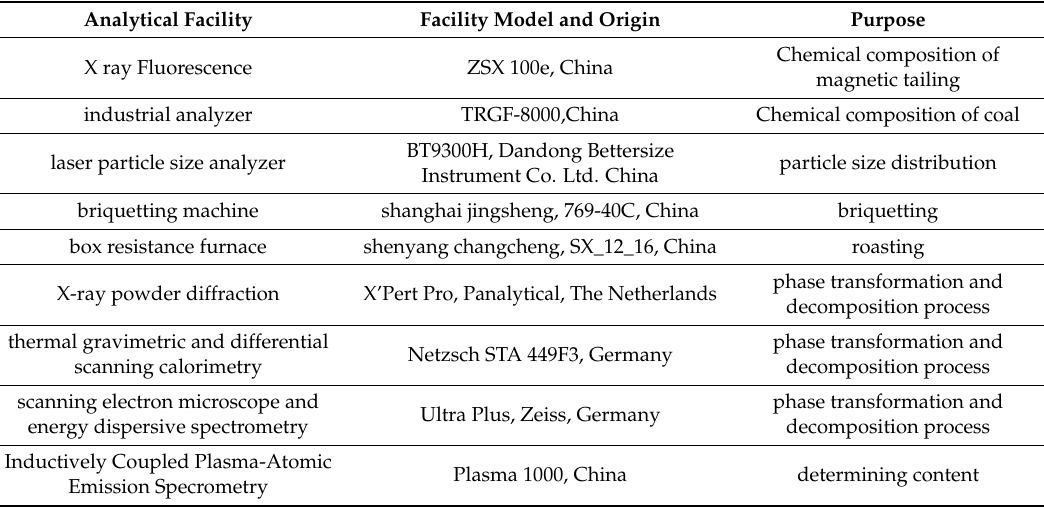
Table 4. Information of the analytical